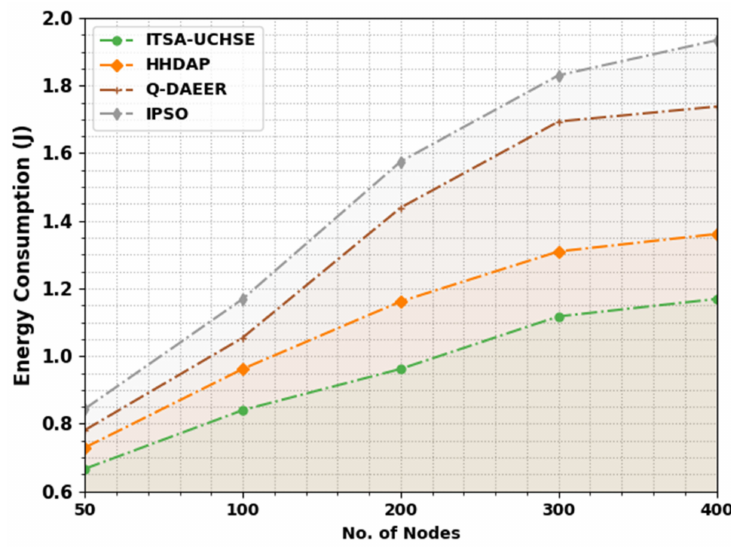
Figure 2. ECON analysis of ITSA-UCHSE system under distinct nodes.